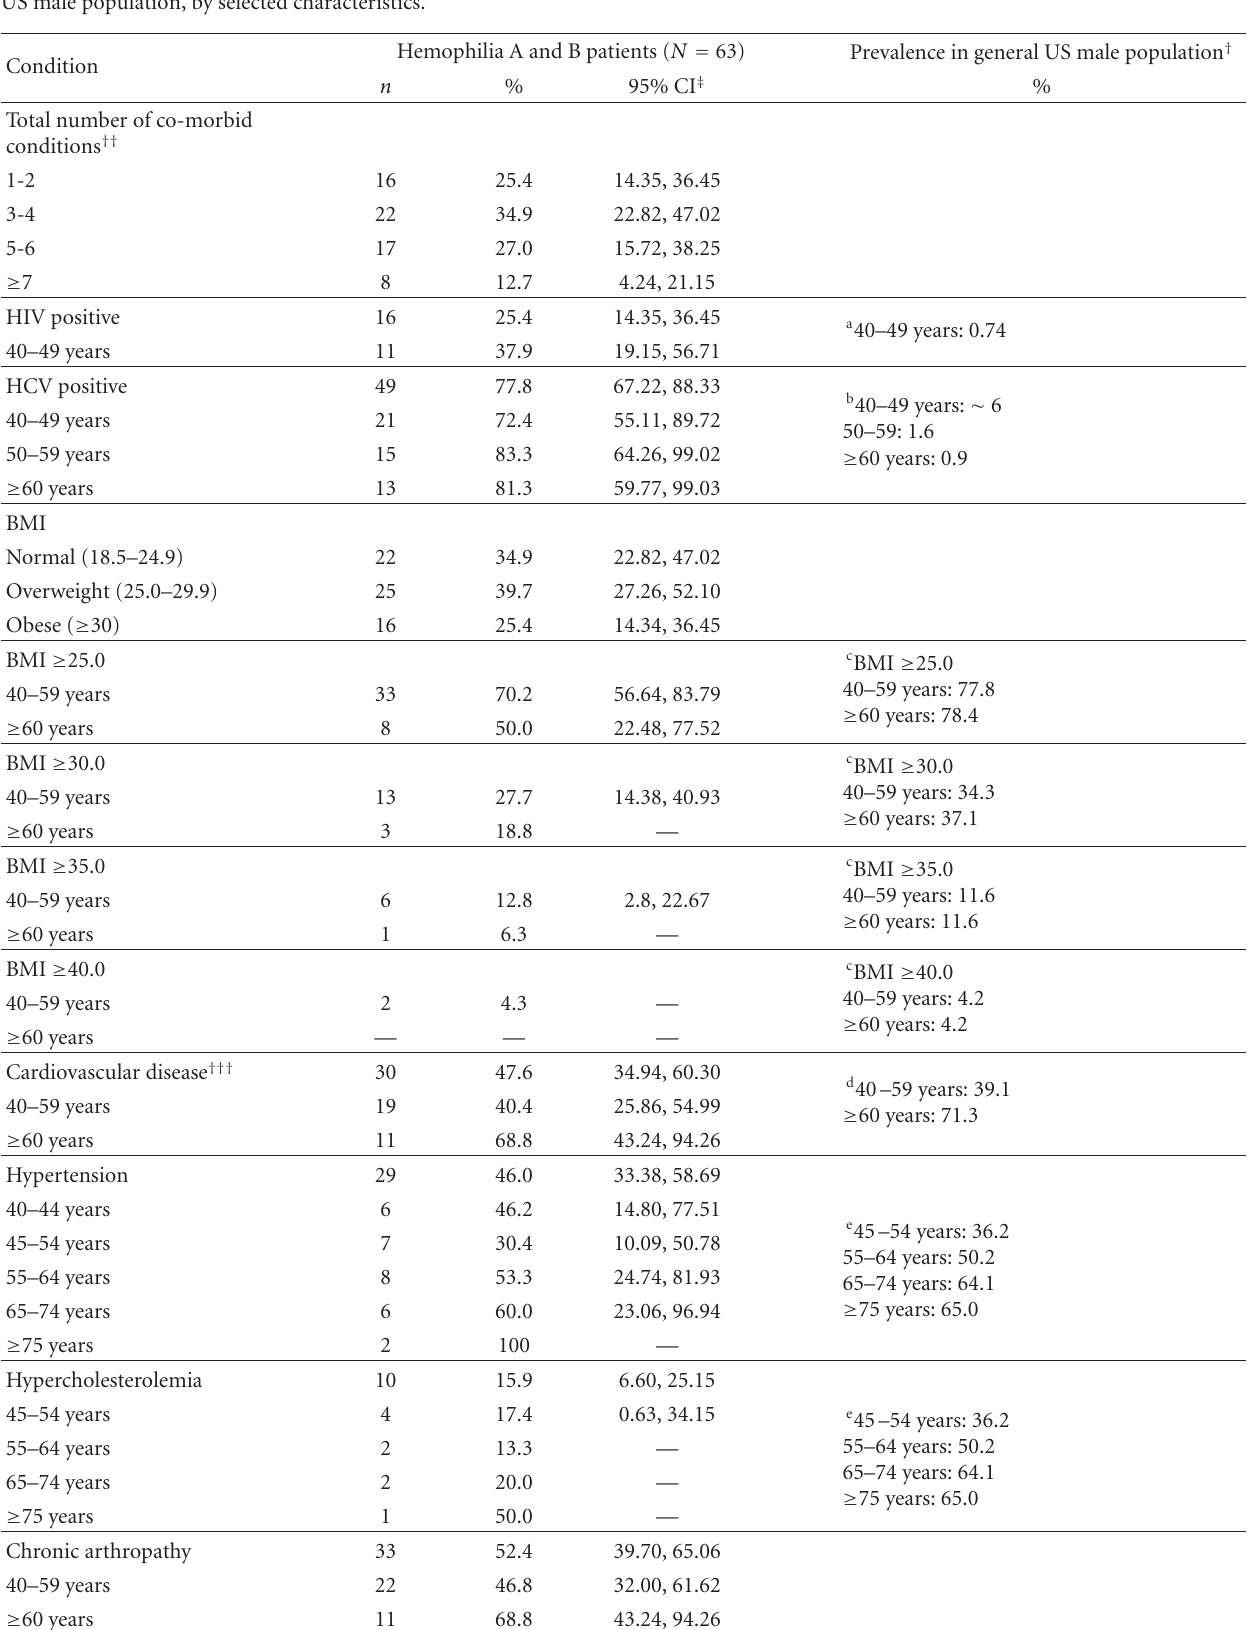
Table 3: Prevalence estimates and 95% confidence intervals of co-morbid conditions among hemophilia patients compared to the general US male population, by selected